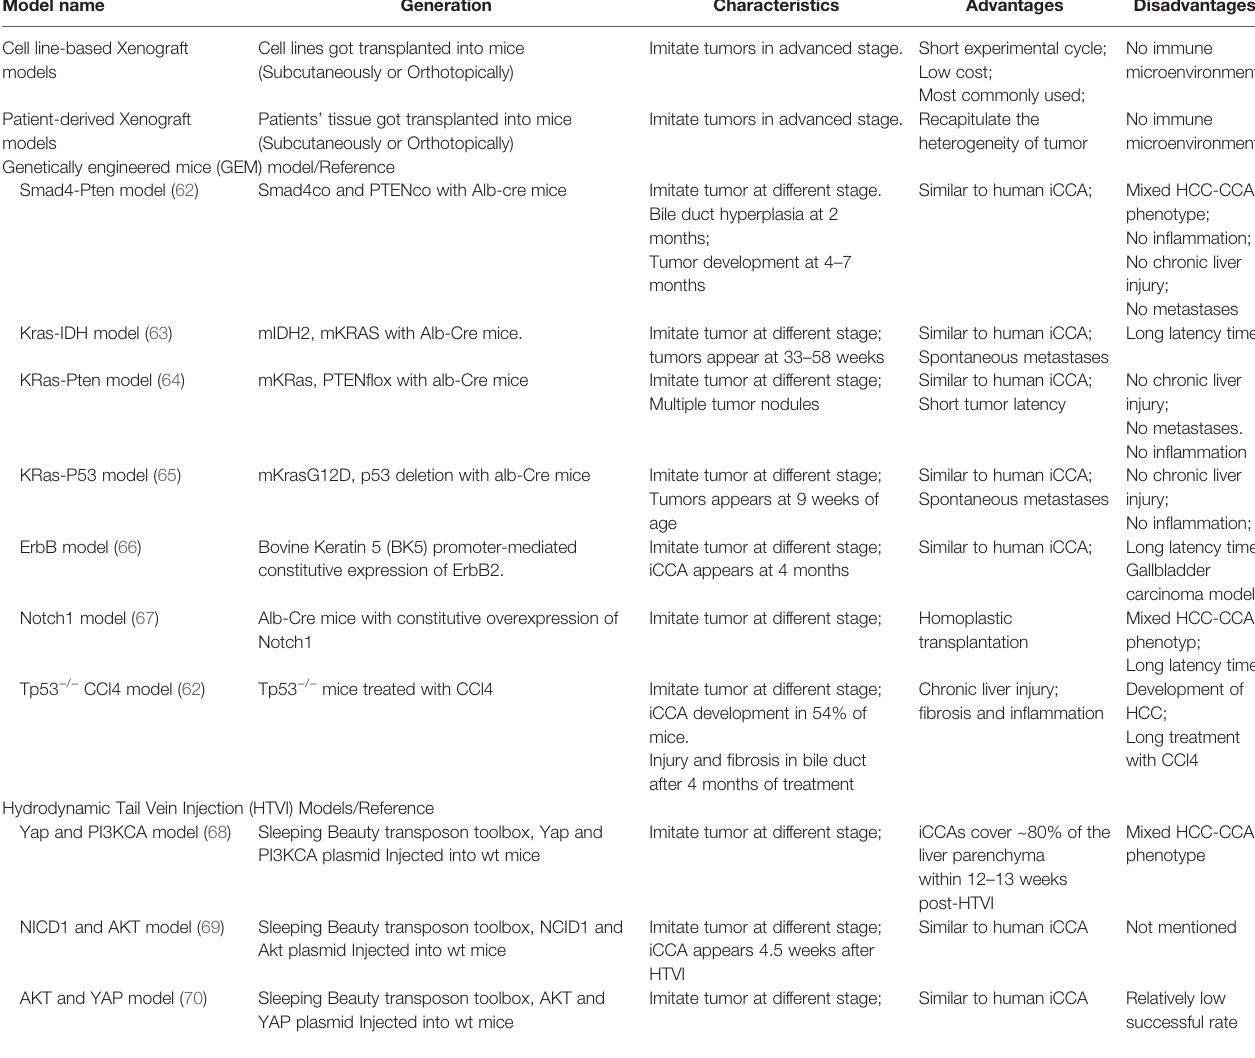
TABLE 2 | Animal models frequently used in CCA and their